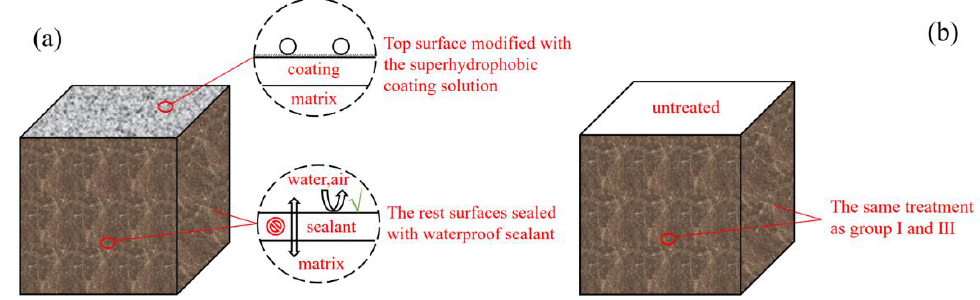
Figure 1. ( a ) Preparation of the treatment of the specimens in group I and III; ( b ) the top surfaces of specimens in group III and IV were untreated.